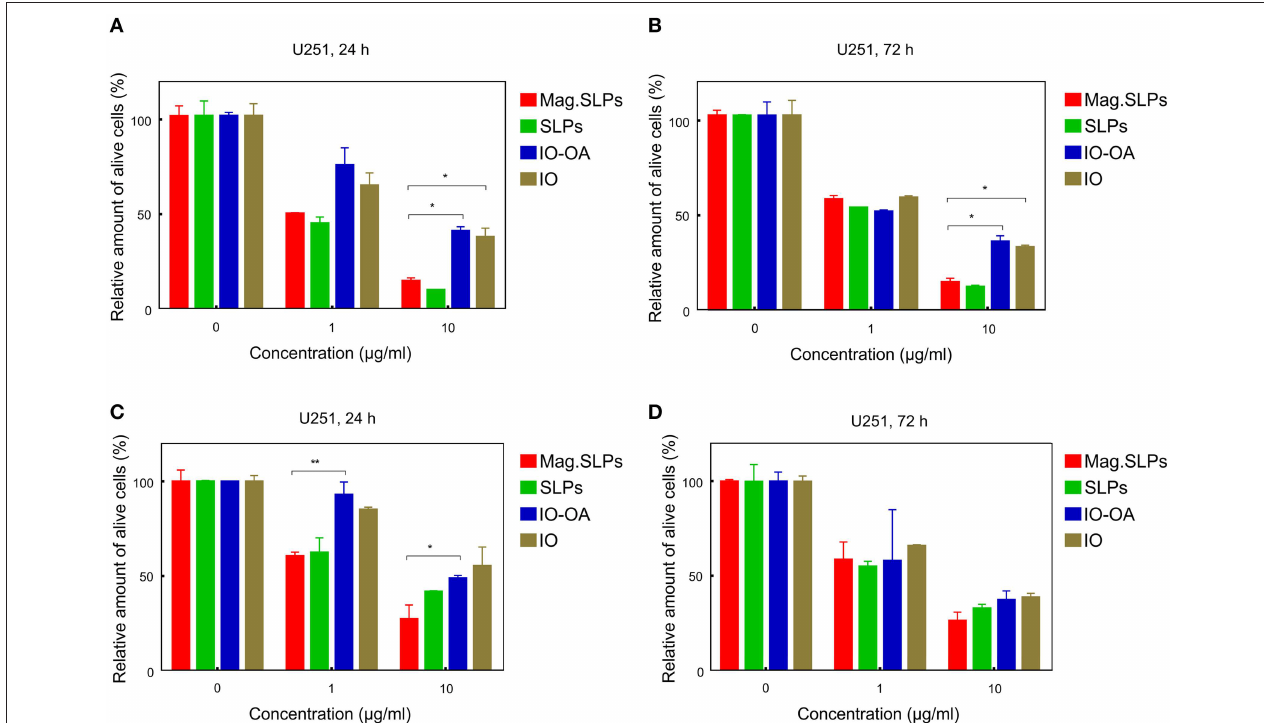
FIGURE 10 | Cytotoxicity of mag.SLPs, SLPs, IO-OA, and IO particles against human glioblastoma U251 cells determined by (A,B) trypan blue exclusion test and (C,D) MTT assay after (A,C) 24 and (B,D) 72h of treatment. * p ≤ 0.05 and ** p ≤ 0.01 compared to the mag.SLPs.